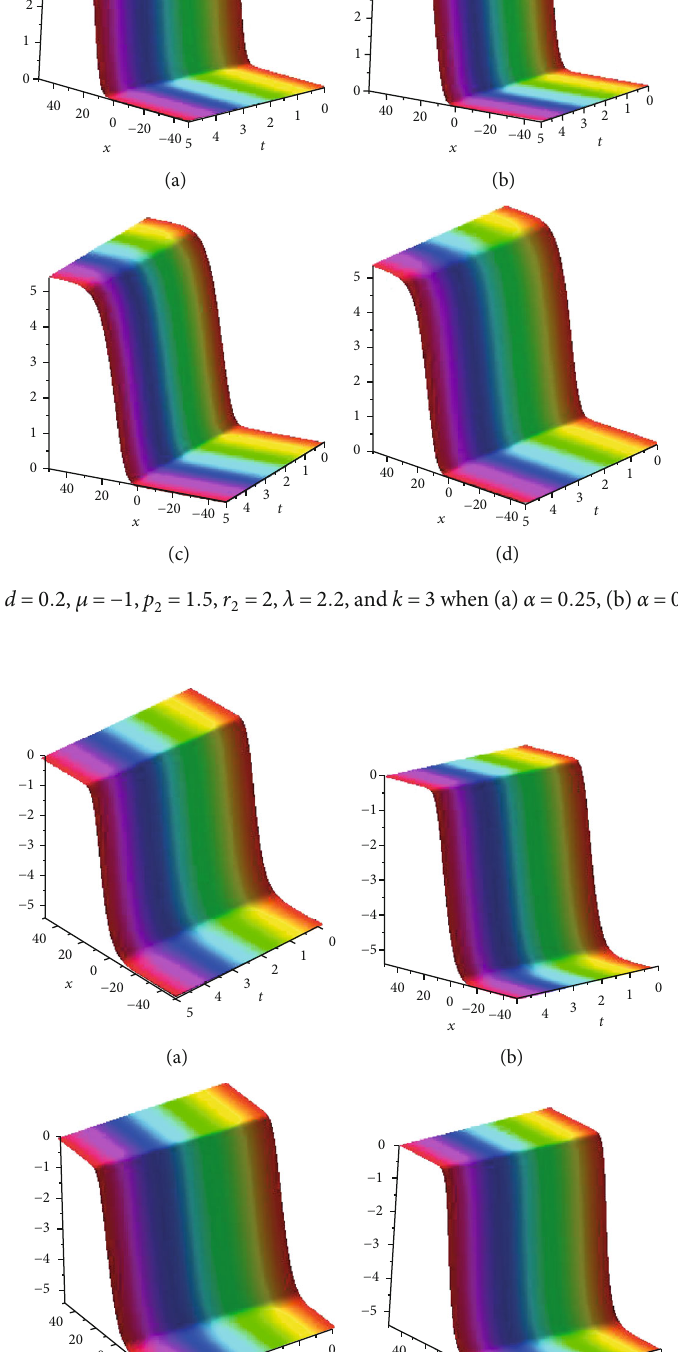
Figure 2: The 3D plot of (27) at d = 0 : 2, μ = − 1 , p and (d) α = 0 : 99